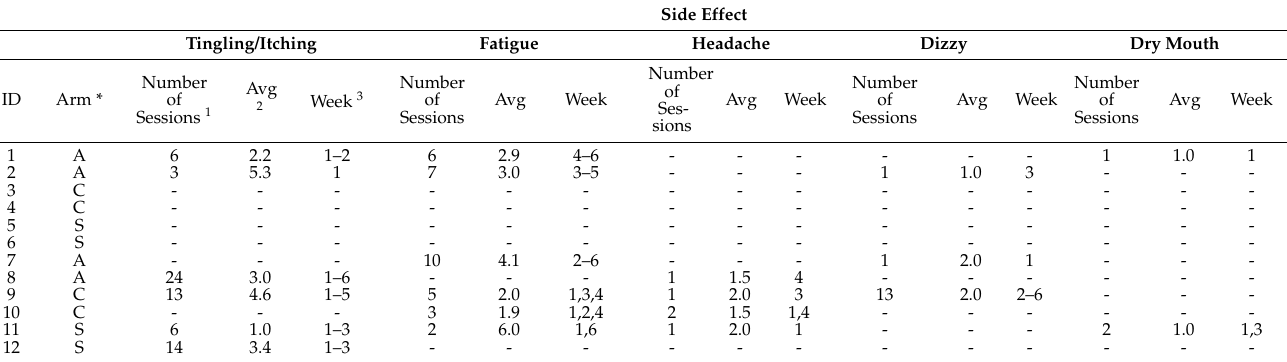
Table 2. Reported side effects for each participant.